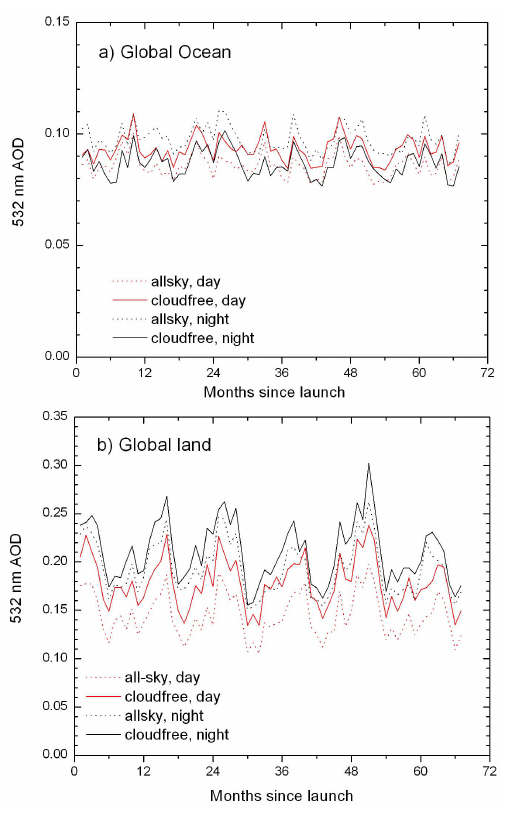
Fig. 4. Monthly-mean 532nm AOD time series. (a) Global ocean. (b) Global land.